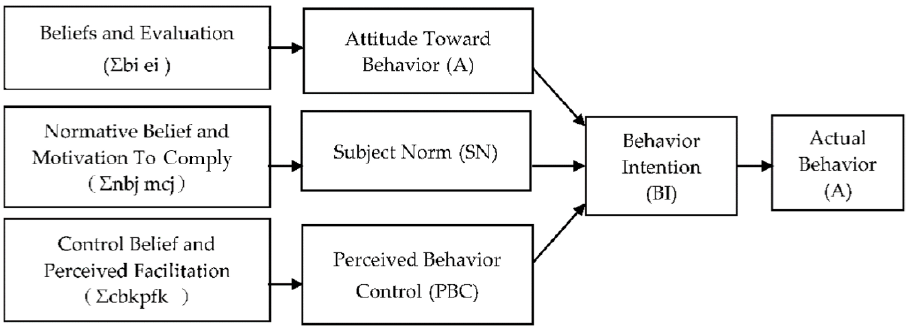
Figure 2. Theory of Planned Behavior (Source: [49]).